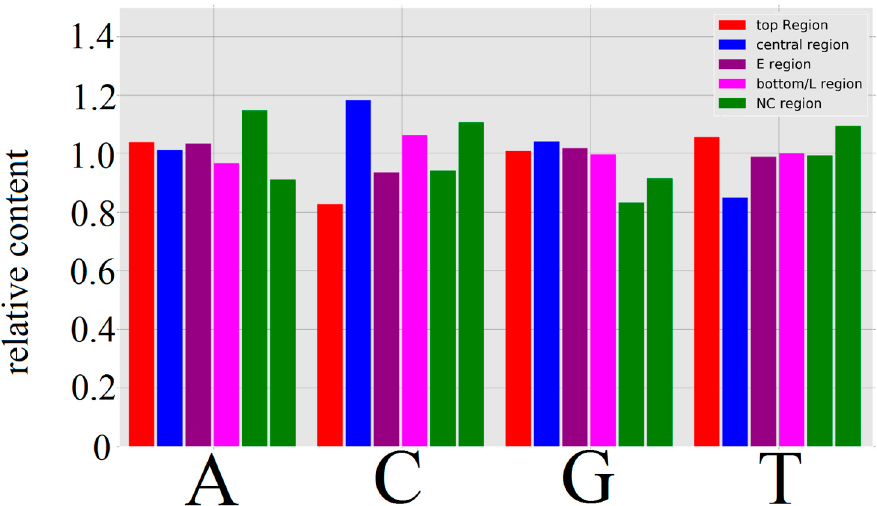
Figure 2. Histogram of monomer contents of different regions relative to the monomer content of the whole genome of HPV4. The top region ( red ) is associated to the genes E1, E6, and E7. The central region ( blue ) is associated with E2, E4, and E5. The E region ( purple ) is the region covered by all early genes. The bottom/L region ( magenta ) is associated with the late genes (L1, L2). The two NC regions ( green ) on the left and right are the non-coding region at the top and bottom of the linear representation used in Figure 1, respectively.